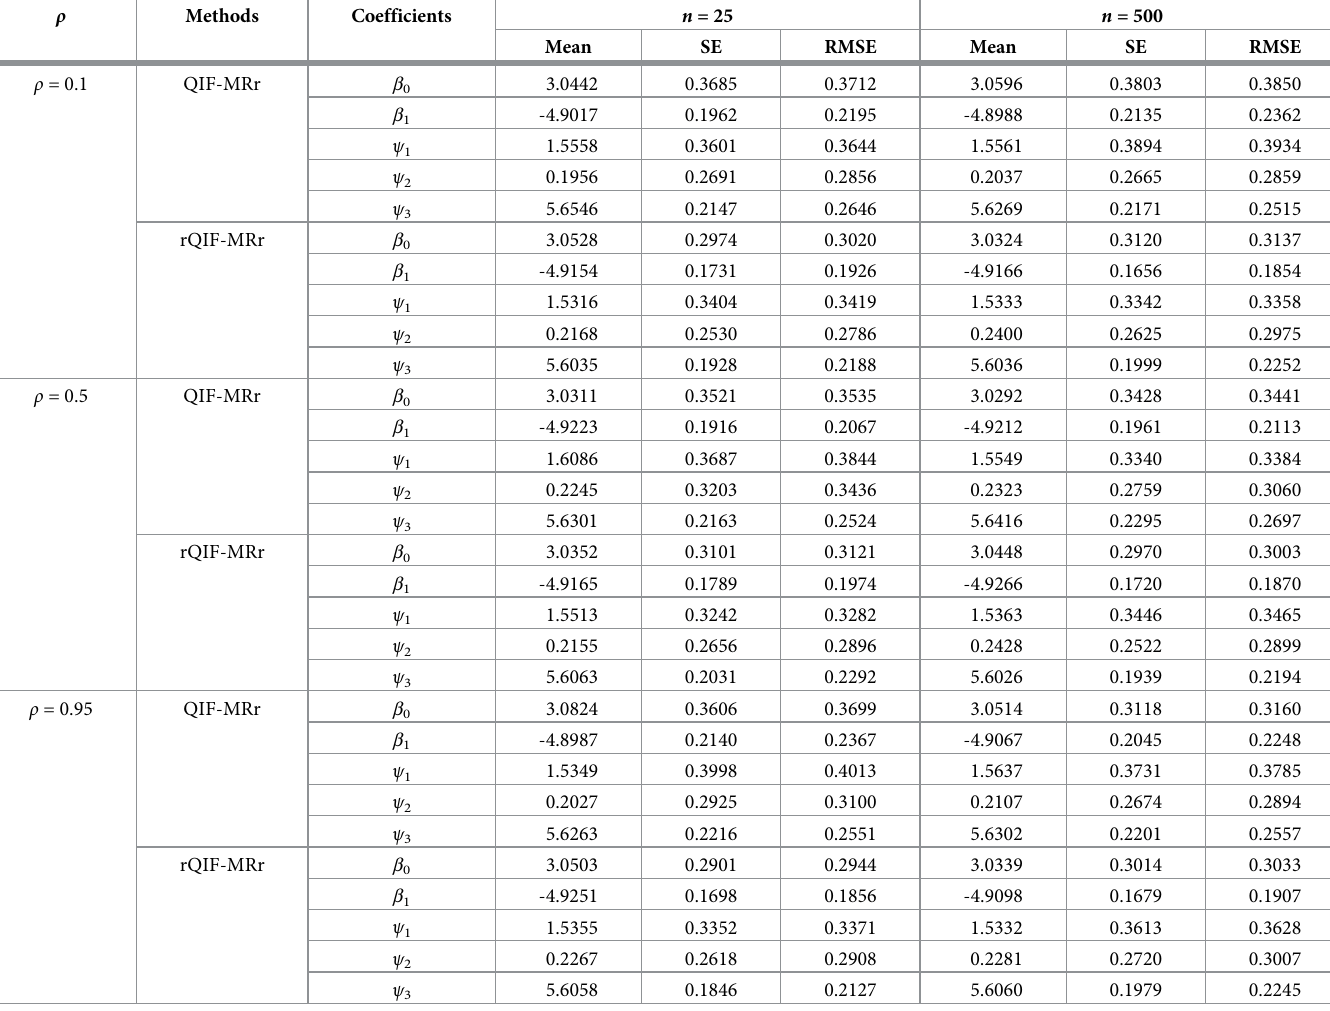
Table 1. Parameter estimation for correctly specified working correlation structure of the QIF-MRr and rQIF-MRr with different correlation values, ρ